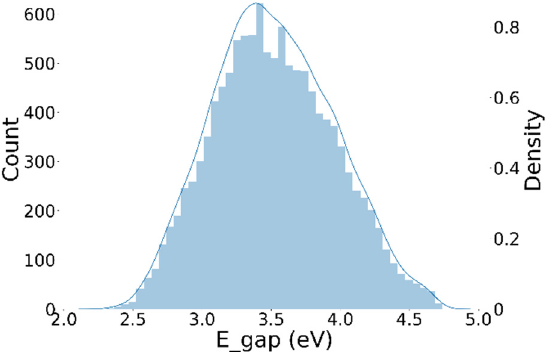
Figure 8. Distribution of energy gap data from the Porphyrin Based Dyes